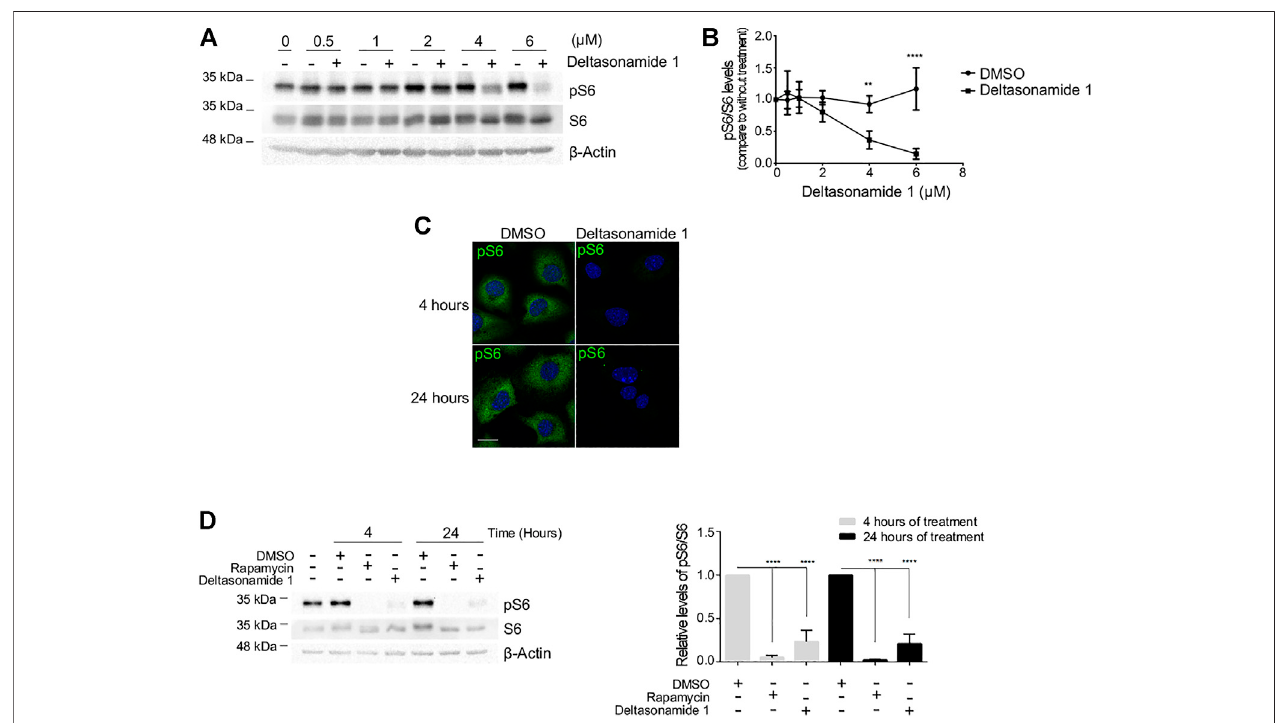
FIGURE2 | Deltasonamide 1 decreases S6 phosphorylation levels in Tsc2-null MEFs (A) . Tsc2-null MEFs treated with DMSO or Deltasonamide 1 (0.5 – 6 µM) for 24 h. Lysates were characterized by immunoblotting of the indicated proteins. pS6, S6 total and β -actin (loading control) (B) . Densitometric analysis of pS6 levels normalized to total S6 levels (C) . Tsc2-null MEFs treated with DMSO or Deltasonamide 1 (6 µM) for 4 and 24 h pS6 (green) levels were analyzed by immuno fl uorescence and confocal microscopy. Hoechst stained the nuclei (blue) (D) . Left, Tsc2-null MEFs treated with DMSO, rapamycin (20 nM), or Deltasonamide 1(6µM)for4and24h. Lysateswere characterized byimmunoblottingofthe indicatedproteins.Right,densitometricanalysisofpS6levelsnormalized to total S6 levels. Results are representative of at least three independent experiments. Data are expressed as the mean ± SD ( p <